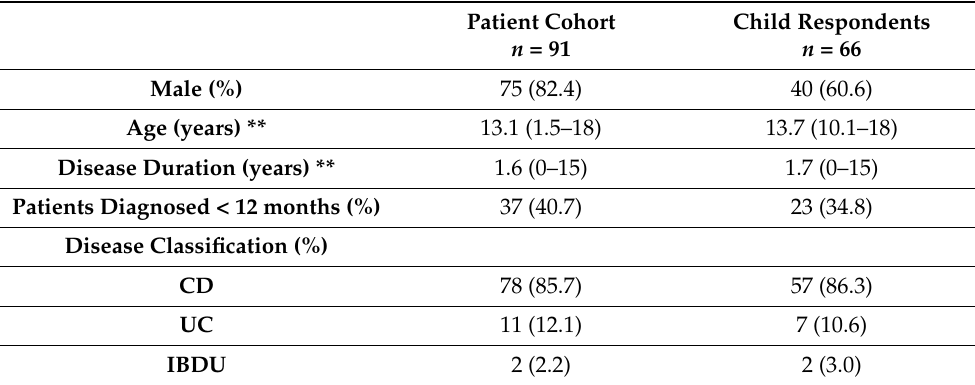
Table 1. Patient population